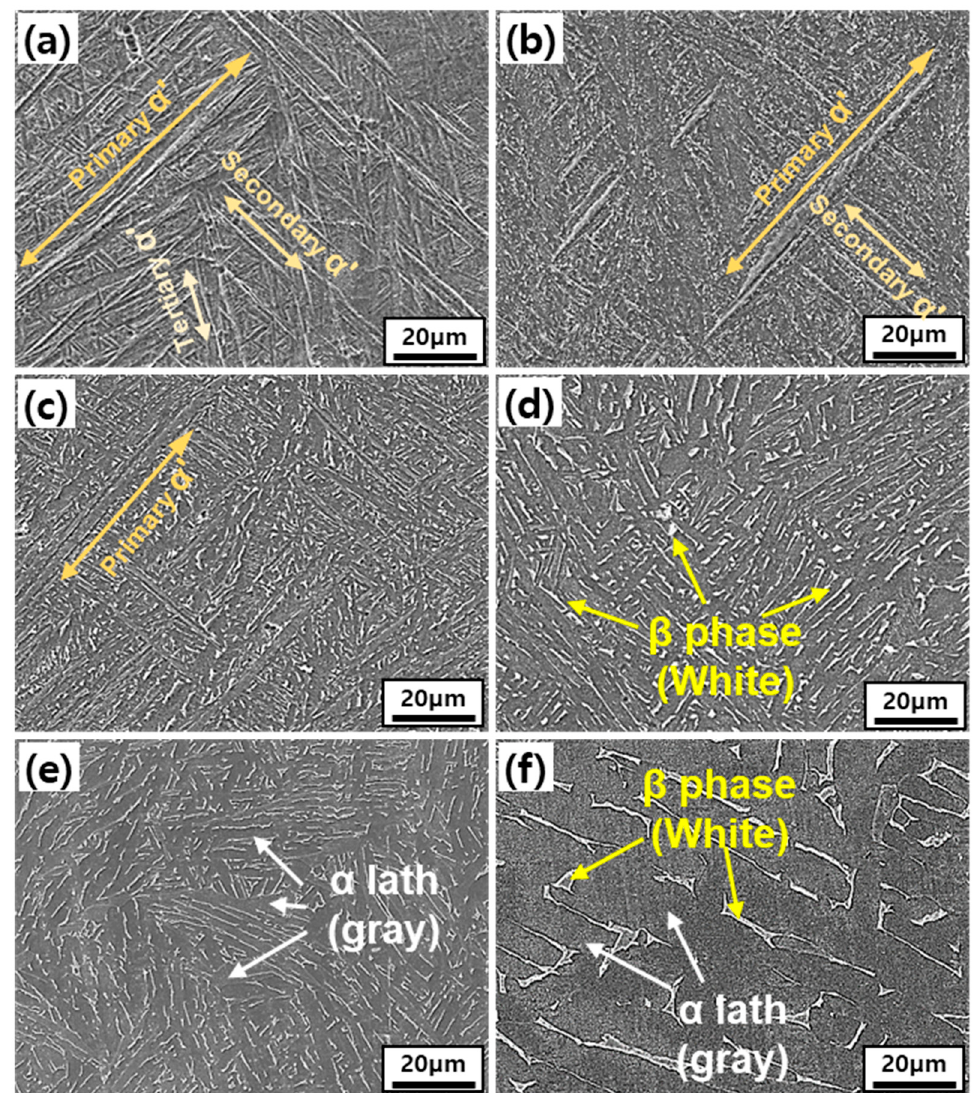
Figure 4. SEM images of as ‐ built and heat ‐ treated SLM Ti ‐ 6Al ‐ 4V. ( a ) As ‐ built, ( b ) 650 °C, ( c ) 750 °C, ◦ C, ( e ) 900 ◦ C, and ( f ) 1000 ◦ ( d ) 800 °C, ( e ) 900 °C, and ( f ) 1000 °C . ( d ) 800